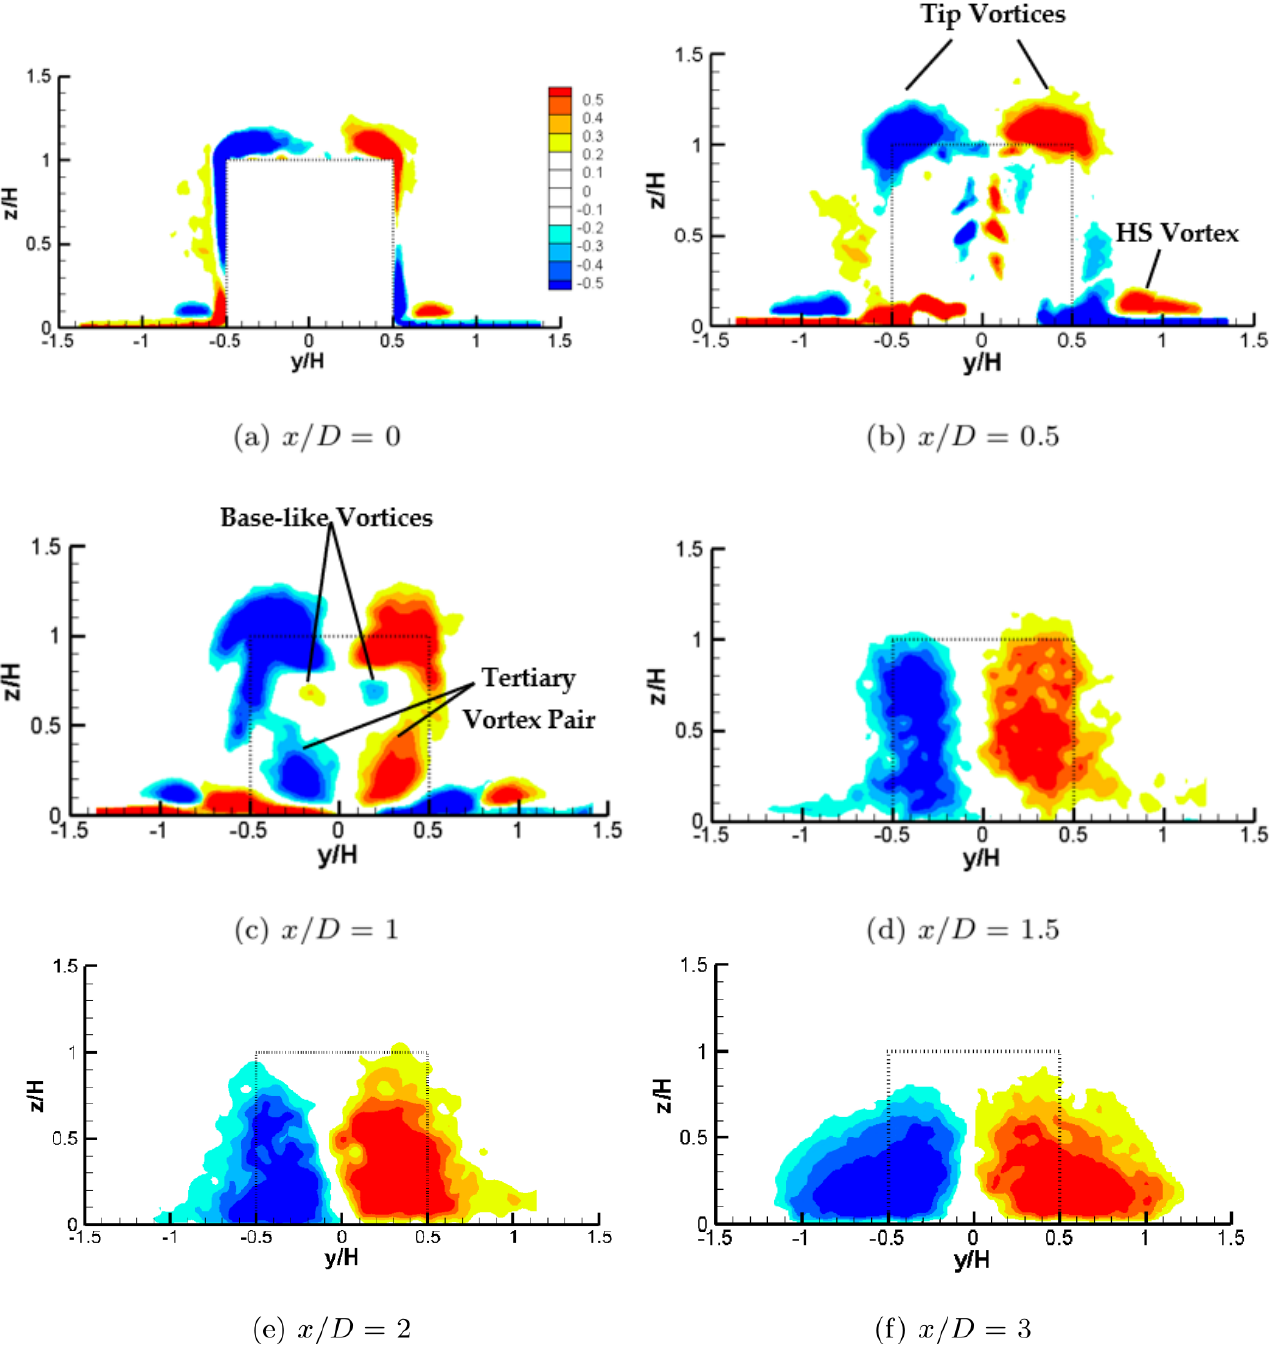
Figure 5. Dimensionless, time-averaged, streamwise vorticity, ω x *, in the wake of cylinder in x / D = x / H = 0, 0.5, 1.0, 1.5, 2.0, and 3.0. Red shades represent positive counter-clockwise vorticity, blue shades represent negative clockwise rotation.